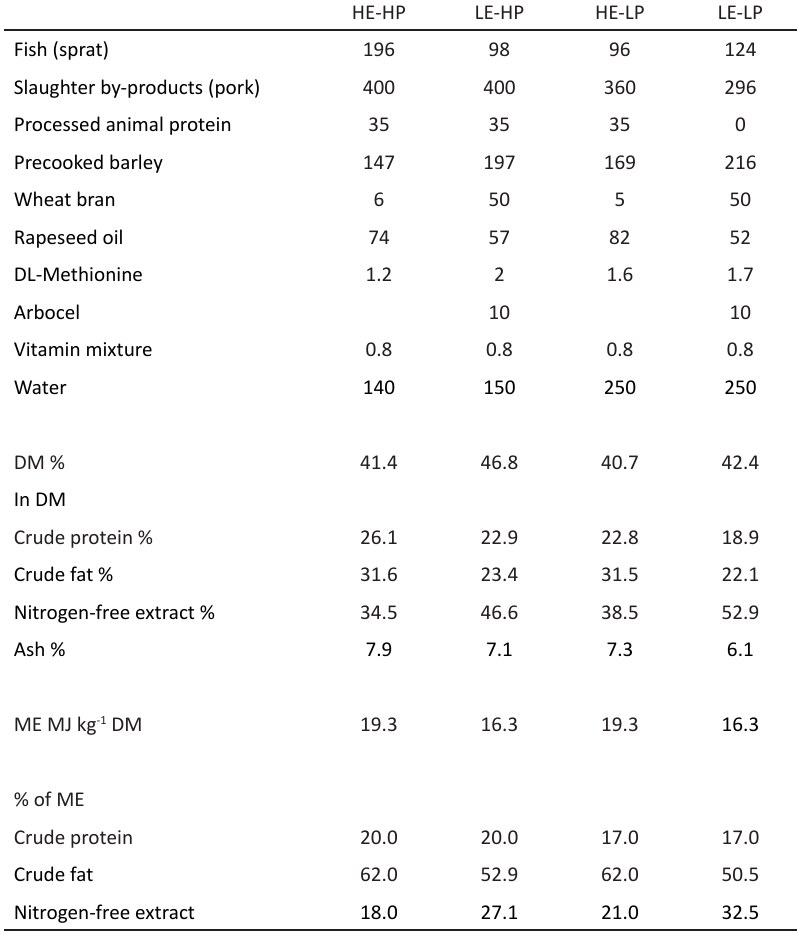
Table 1. Ingredients (g kg -1 ) and calculated composition of the experimental